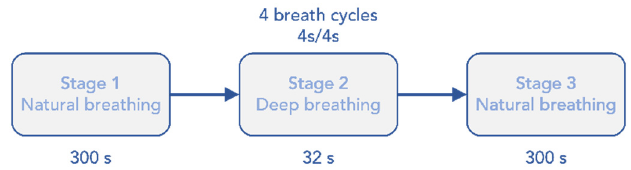
Figure 2. Stages of the experiment.